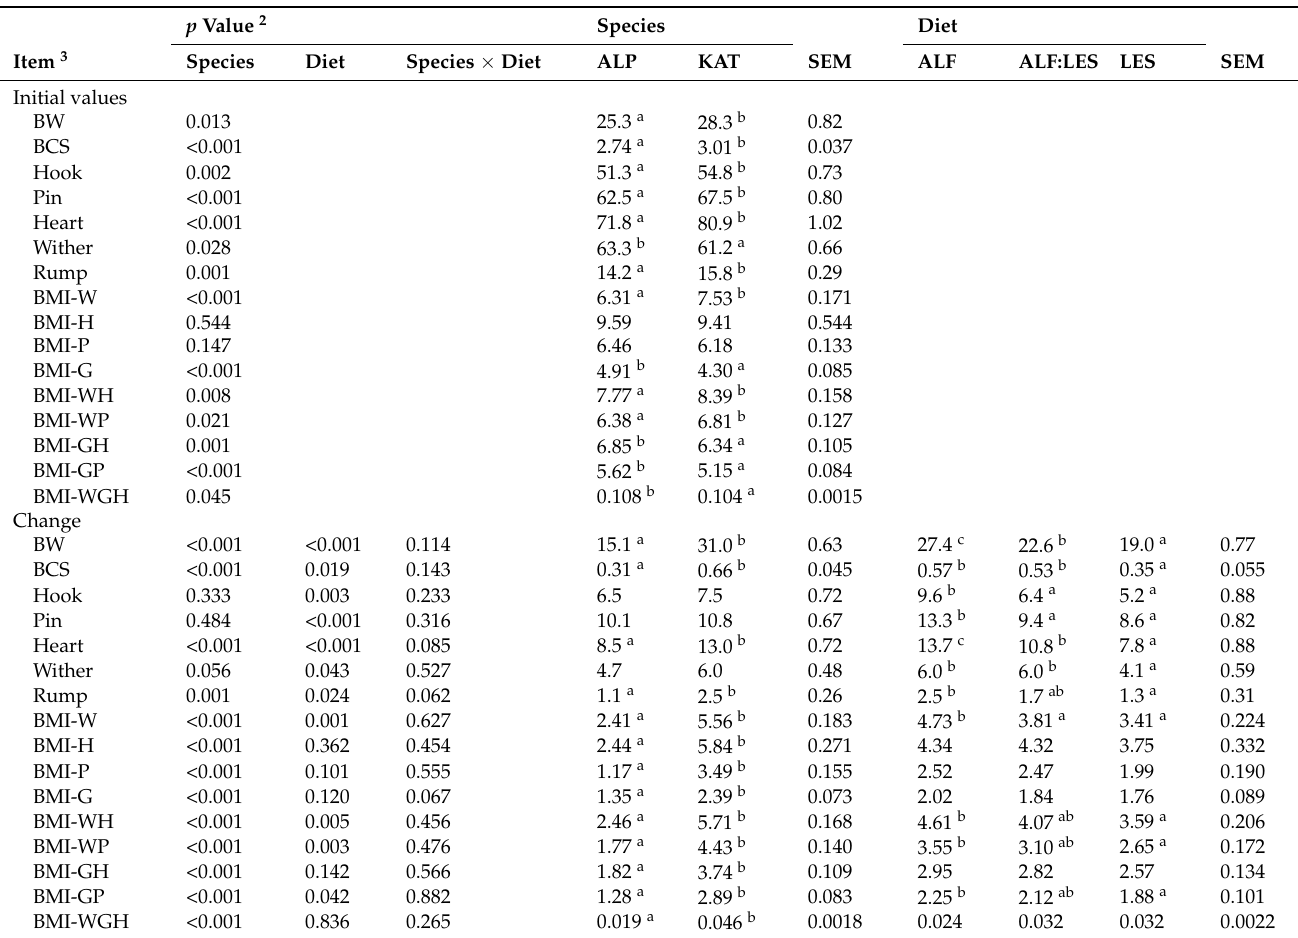
Table 1. The effects of species and diet on initial body weight, body condition score, linear measures, and body mass indexes and change during the experiment 1